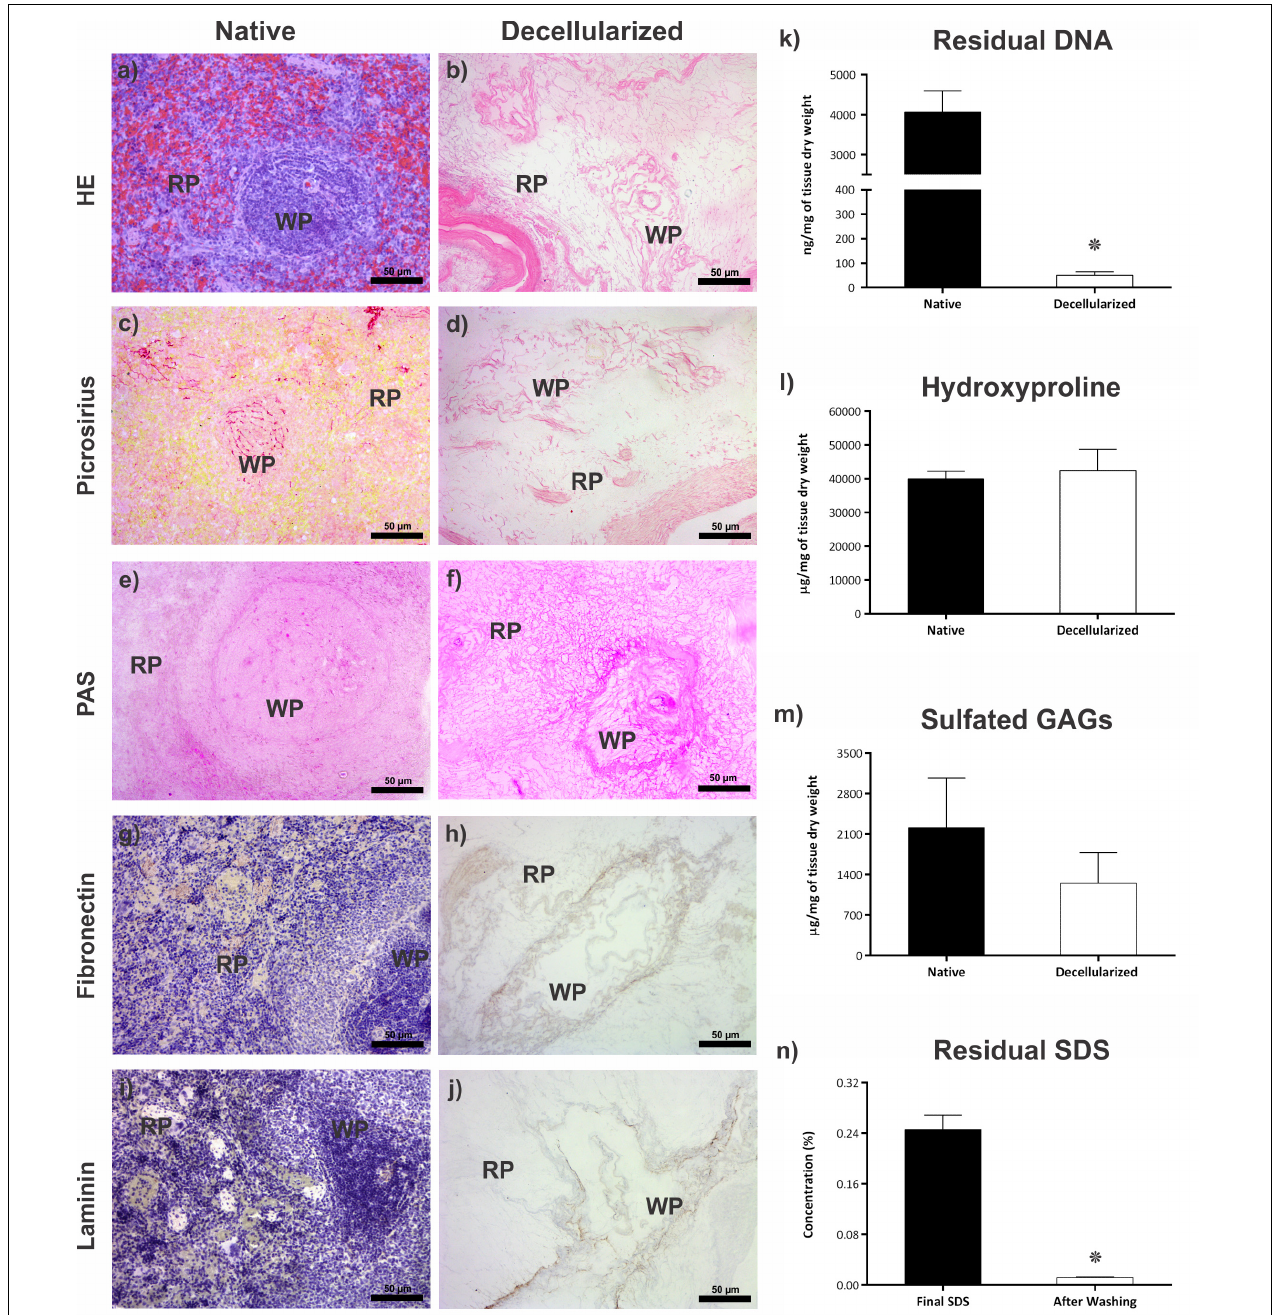
FIGURE 2 | Evaluation of the decellularization process. (a,b) Representative images of the native spleen and decellularized scaffold stained by HE, showing the presence of cells with their nuclei in the native and their absence with the maintenance of ECM in the decellularized scaffold. (c,d) Representative images of the native organ and the scaffold stained with Picrosirius red, demonstrating the preservation of collagen fibers after decellularization. (e,f) Representative images of native organ and scaffold stained with PAS, showing the preservation of glycoproteins after decellularization. (g,h) Representative images of immunohistochemistry analysis of fibronectin glycoprotein in native tissue and its maintenance after decellularization. (i,j) Representative images of immunohistochemistry analysis of laminin glycoprotein in native tissue and its maintenance after decellularization. (k) Bar graph showing the difference in residual DNA content between the native spleen ( n = 4) and the decellularized scaffold ( n = 6). (l) Bar graph showing that there is no difference between the collagen content (hydroxyproline) between the native spleen and the scaffold ( n = 4). (m) Bar graph showing that there is no difference in the content of sulfated GAGs between the native spleen and the decellularized scaffold ( n = 4). (n) Bar graph showing the difference in the concentration of residual SDS content in the scaffold ( n = 3) at two moments in the decellularization process: effluent collected at the end of the decellularization process; effluent collected after the final H 2 O wash step. All values are represented with mean ± SEM, * p < 0.05. Scale bar: 50 µ m. WP, white pulp; RP, red